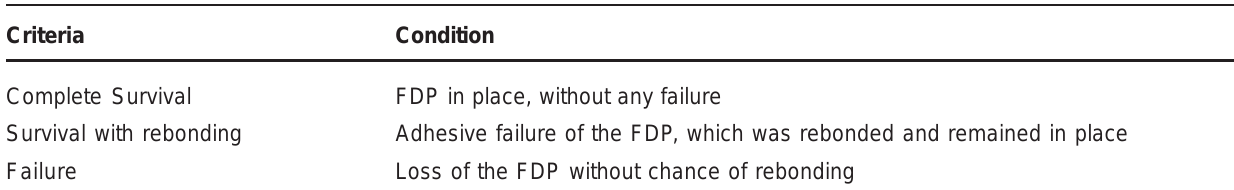
TABLE 1- Criteria used to define the clinical condition of the resin-bonded fixed-partial dentures (modified from Creugers et al. 5 ,